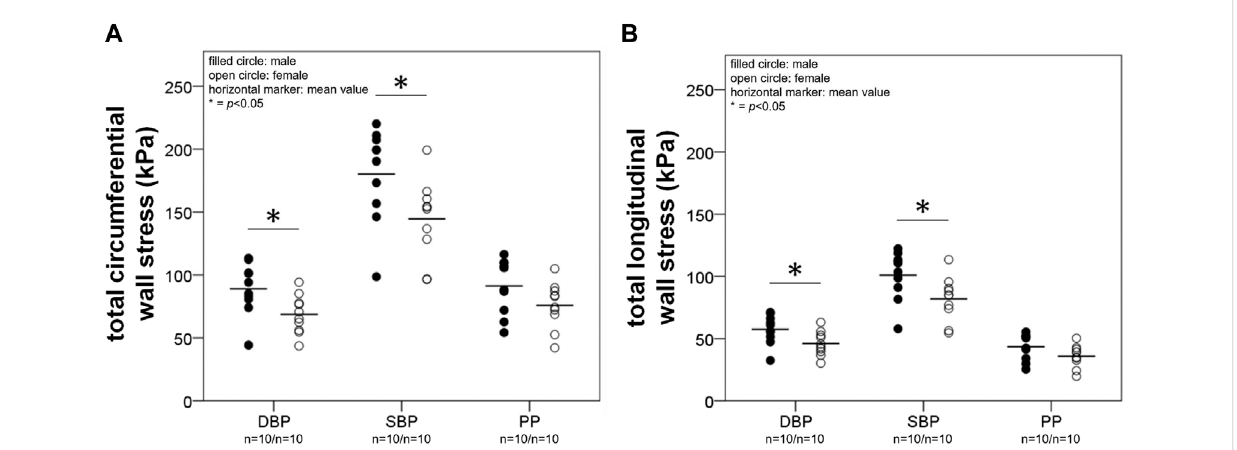
FIGURE 3 A and B depict results from the calculation of total wall stress. Total circumferential (A) and longitudinal (B) stress ( σ tot θ ; σ tot z ) are given at diastolic blood pressure (DBP), systolic blood pressure (SBP)and pulse pressure (PP) for the elderly group. Maleshad higher σ tot θ as well as σ tot z than females at DBP and SBP. Stress at PP denotes pulsatile stress ( Δ σ ), i.e., stress at SBP minus stress at DBP.